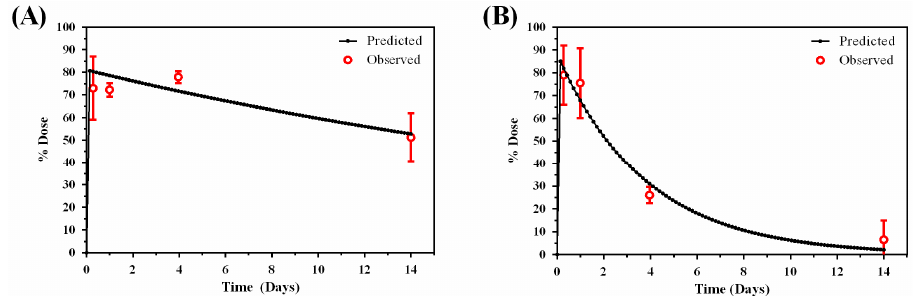
Figure 3. Compartmental modelling estimates for: ( A ) liposome and ( B ) antigen at the muscle.